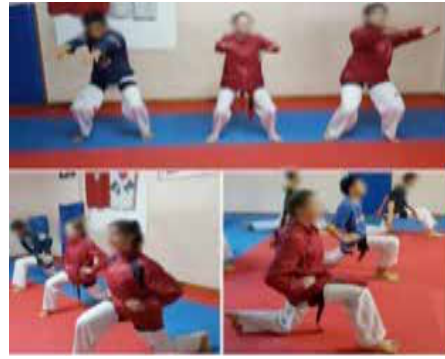
Figure 1. Pliometric Training Program Plyometric training program consists of; squat jump (The legs are spread over the shoulder width, the back is straight and the knees are slightly bent (Fig. 1). The hips are then lowered until they are parallel to the ground and then jumped up strongly at this point. It falls again after 1 second after falling onto two legs), jump to box (Legs are opened at the width of the hips and the body is leaning towards the box. Half-crouching and jumping into the box without waiting), lateral jump to box (Legs are opened at the width of the hips and the body is standing with the lateral facing towards the box. Half-crouched and jumping into the box without waiting. After landing in the box, take a step back down and move again), bounding with rings (It is descended into the rings arranged on the ground by jumping forward with the right and left feet respectively), box drill with rings (Starting from the half-crouching position, the double legs are jumping on adjacent lined rings, two forward and two rearward.